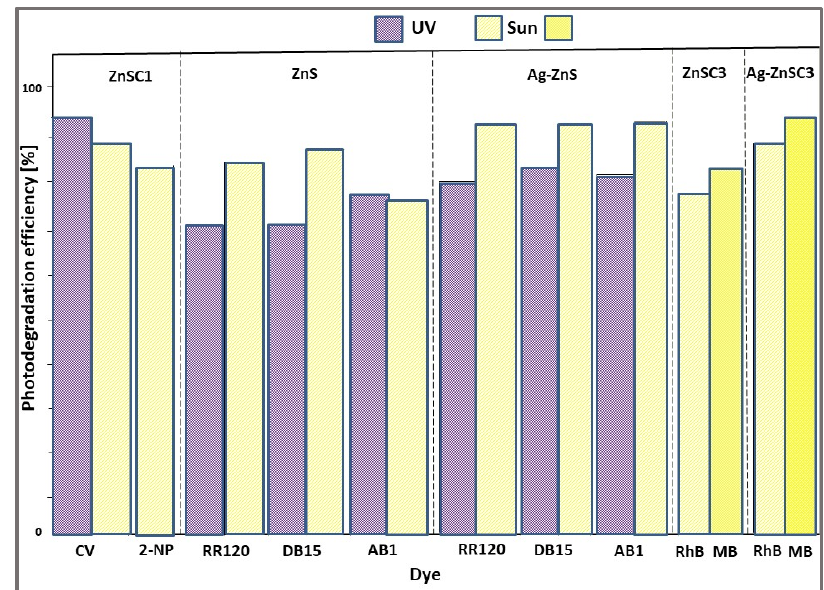
Figure 5. The photocatalytic activity of different ZnS NSs in dye degradation under UV and solar irradiation.